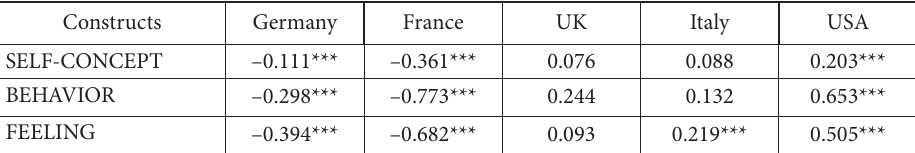
Table A3. Latent means